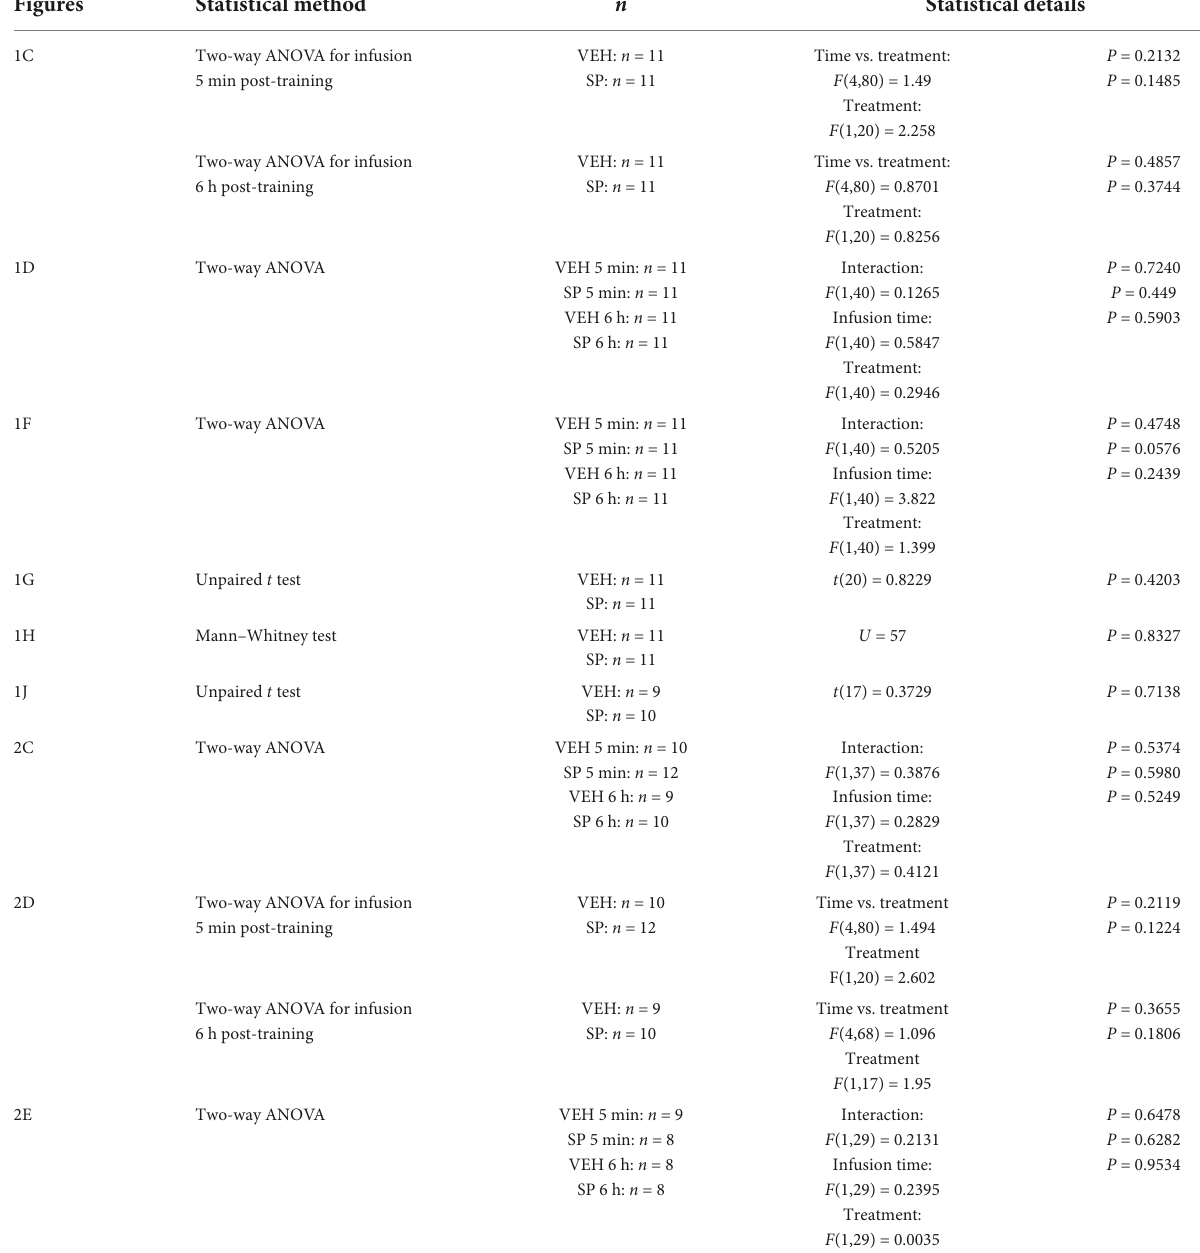
TABLE 3 Detailed statistics for control